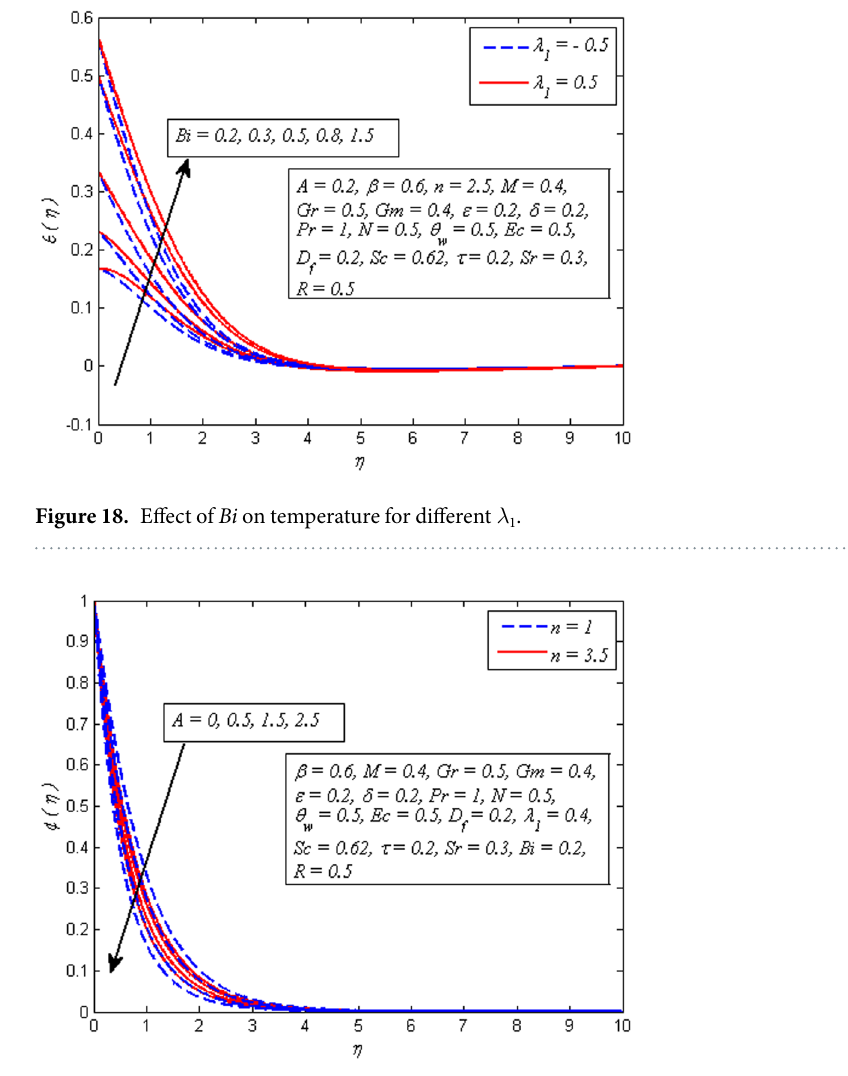
Figure 19. Effect of A on concentration for different n .